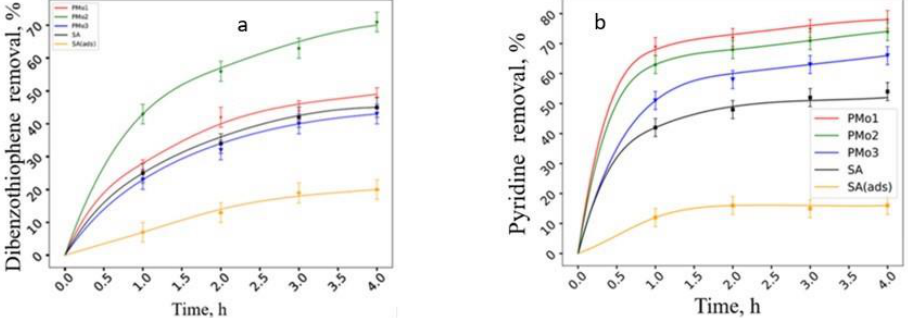
Figure 10. Dibenzothiophene ( a ) and pyridine ( b ) removal versus time.